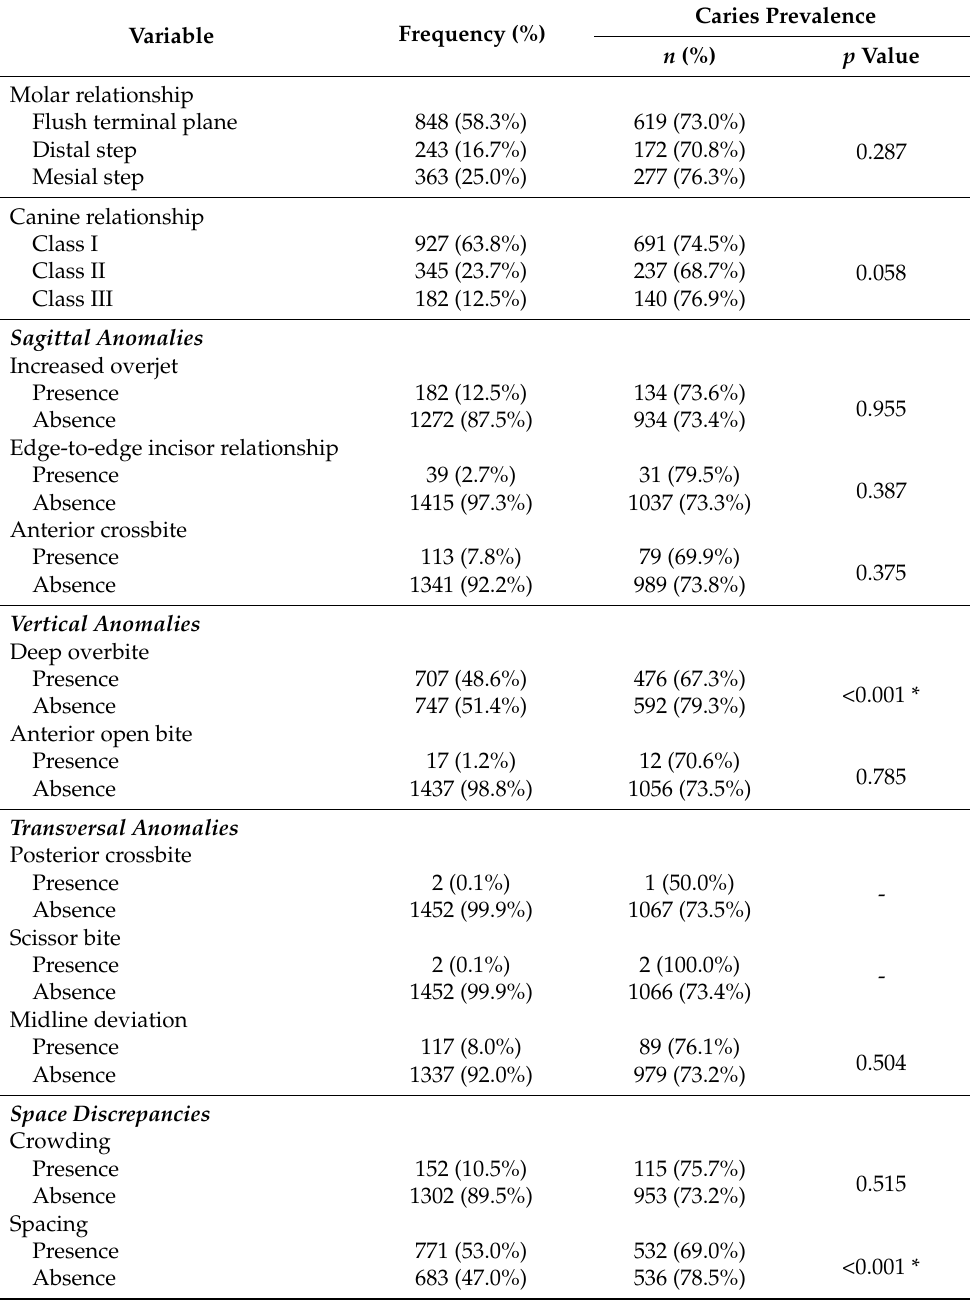
Table 3. Occlusal traits and dental caries of preschool children in Huizhou,